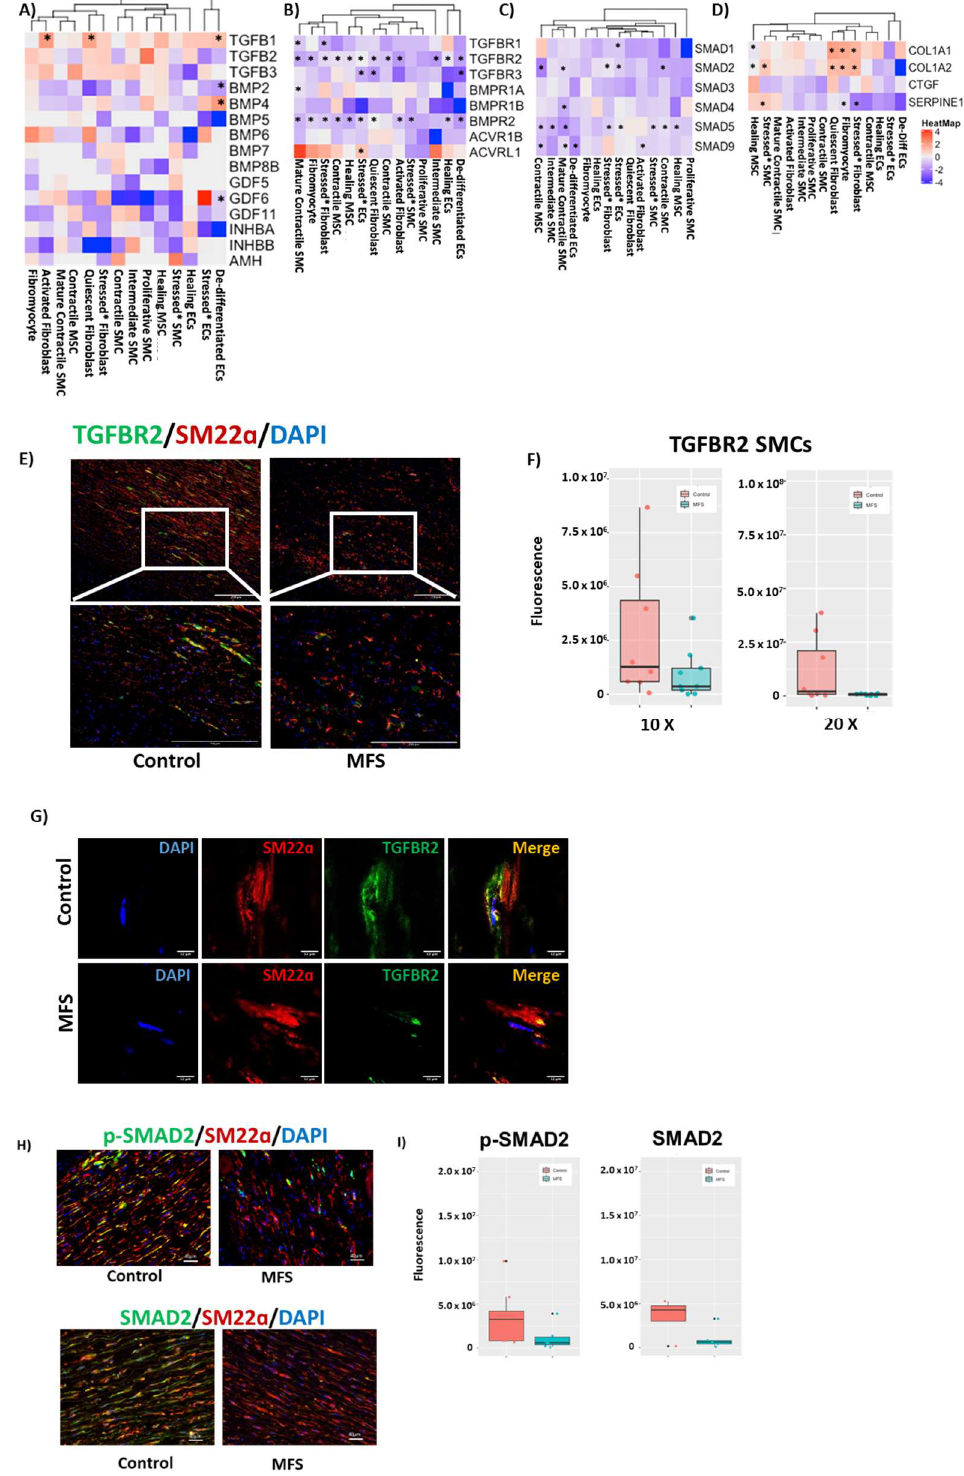
Figure 6. Cell-specific changes in the TGF-β pathway in MFS compared to control. ( A – D ) Cell-specific TGF-β pathway expression including ( A ) TGF-β ligand genes, ( B ) TGF-β receptor genes, ( C ) SMAD genes, and ( D ) target genes. * Clusters with significant differential expression (adjusted p < 0.05). Data are presented as log2FC in MFS compared to control. ( E ) Immunofluorescence shows decreased TGF-β receptor II levels in SMCs in MFS, supporting our single-cell data. ( F ) Immunofluorescence quantification of co-localized TGF-β receptor II and SM22 ɑ shows decreased TGF-β receptor II in SMCs in MFS, consistent with our single-cell data. Quantification was performed using